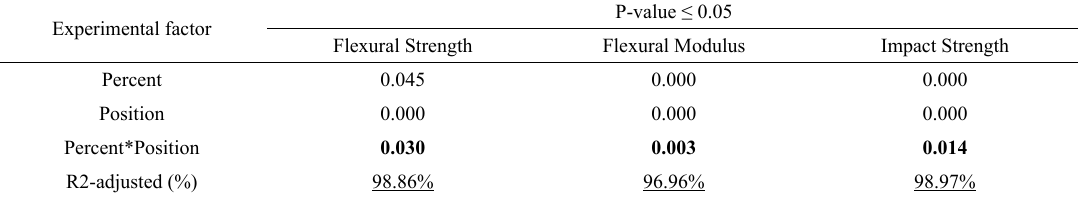
Table 5. Analysis of